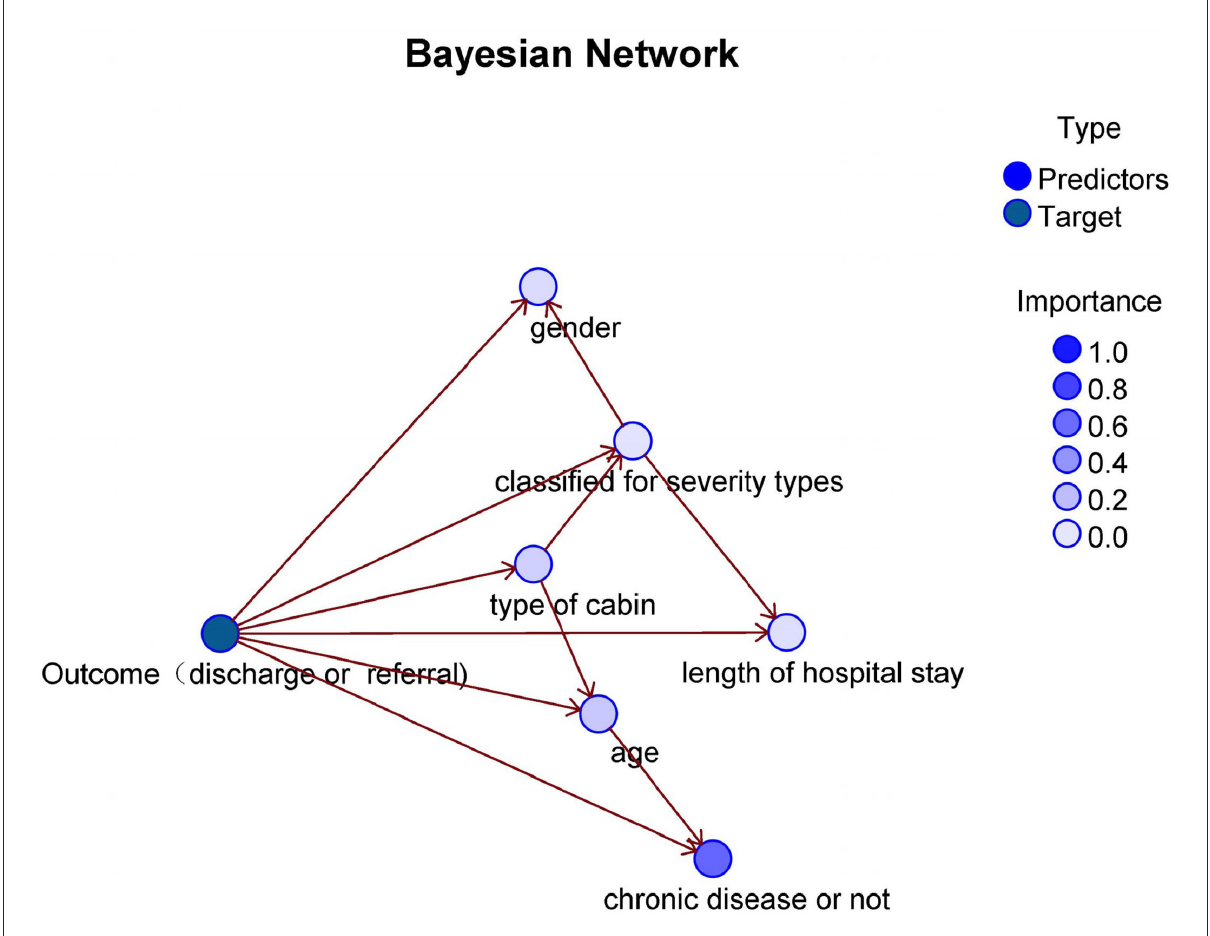
FIGURE4 Directed acyclic graph of Bayesian